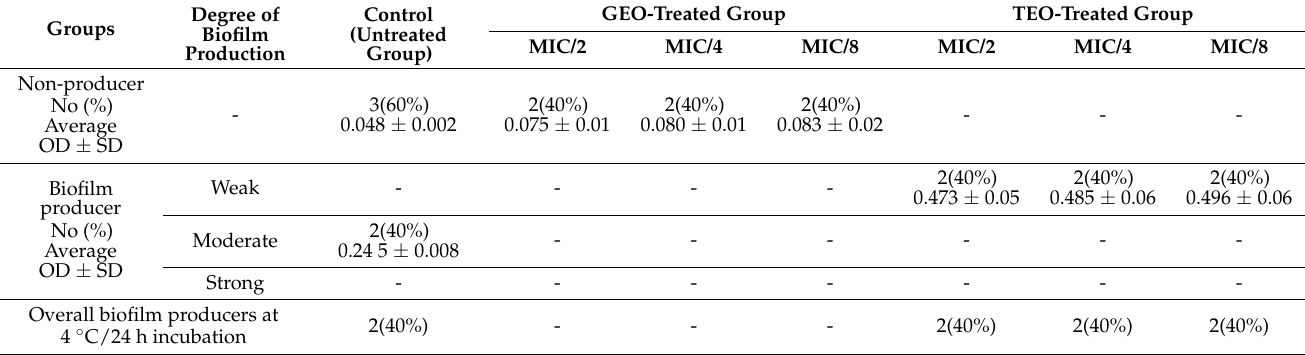
GEO: Garlic essential oil. TEO: Thyme essential oil.SD: Standard deviation. OD: Optical density. MIC of GEO = 1/64. MIC of TEO = 1/32. Regarding GEO concentrations: MIC/2 = 1/128 µ